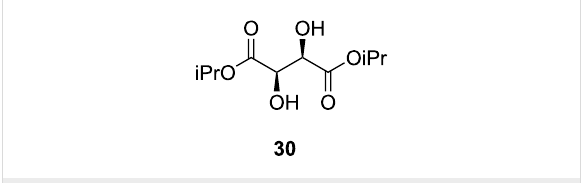
Figure 3: Diisopropyl L-tartrate ( 30 ) used as a chiral modifier for NMR determination of ee.